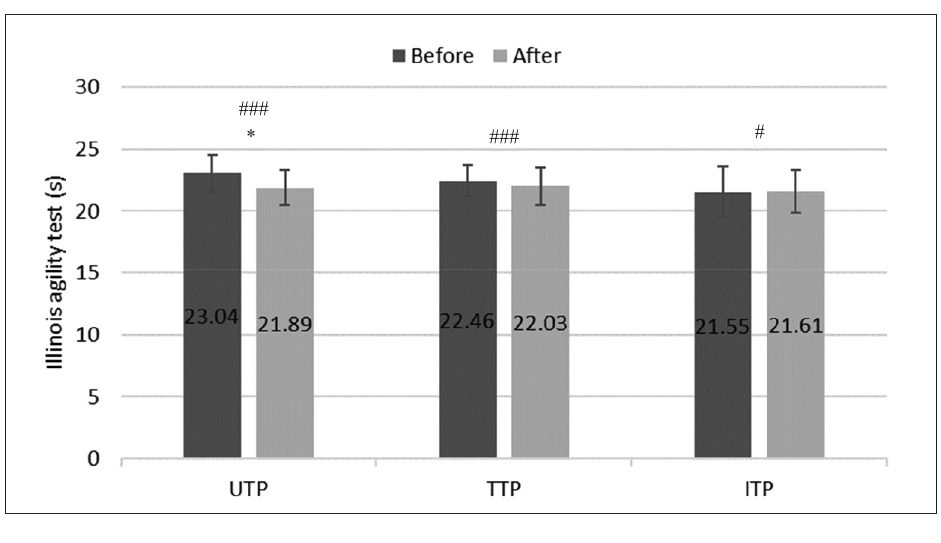
Figure 4. Indicators of vertical jump swinging the arms backward (cm) of mini-basketball play-